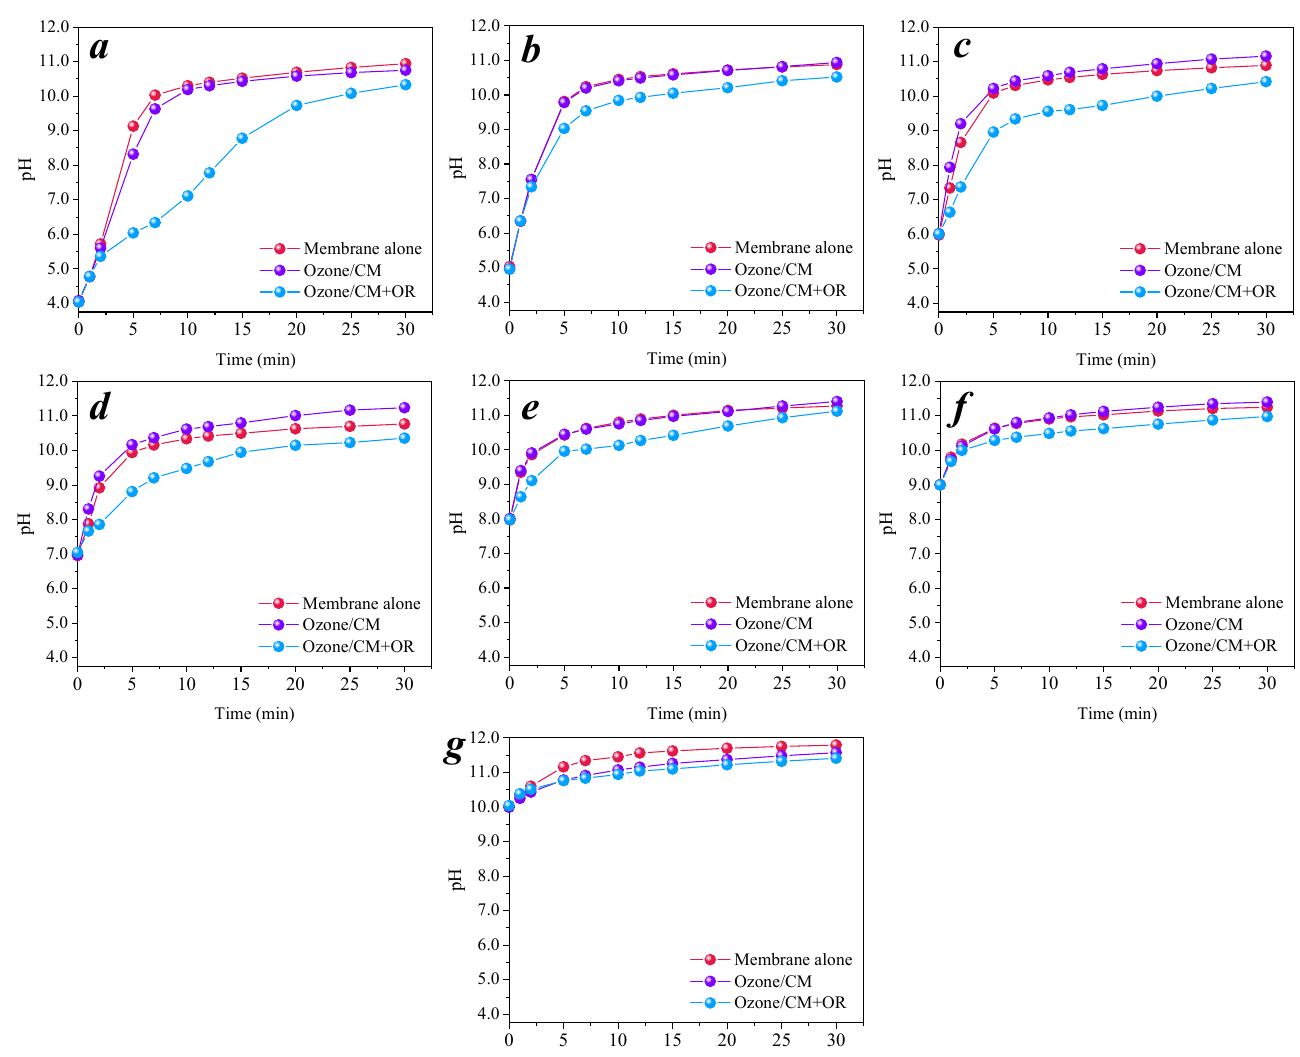
Figure 6. Change trends of pH in solution with different initial pH values. ( a ) pH initial = 4.0; ( b ) pH initial = 5.0; ( c ) pH initial = 6.0; ( d ) pH initial = 7.0; ( e ) pH initial = 8.0; ( f ) pH initial = 9.0; ( g ) pH initial = 10.0. Conditions: [O 3 ] = 0.5 mg L − 1 , [nitrobenzene] 0 = 0.064